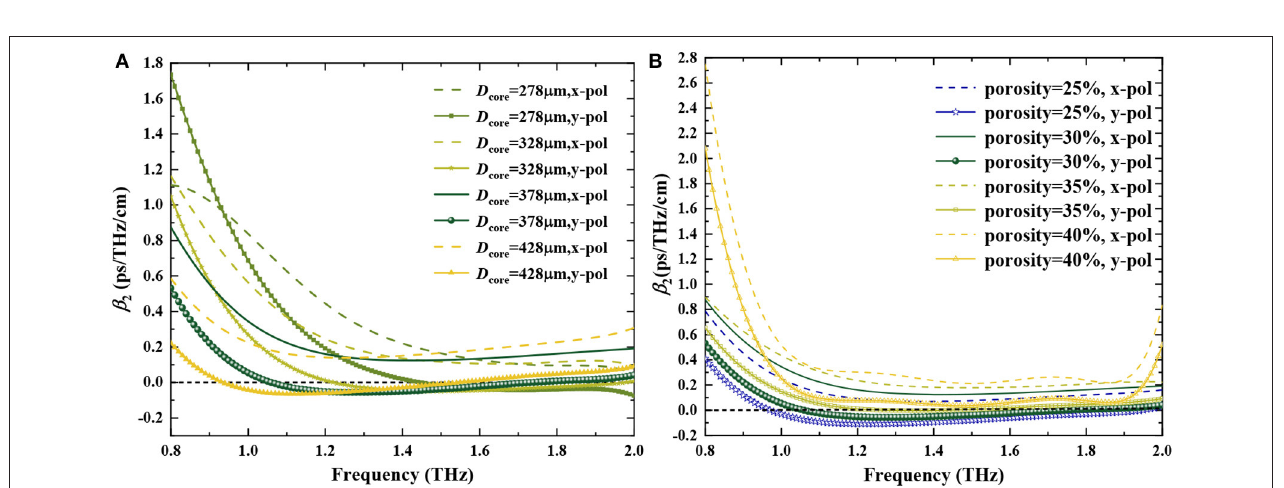
FIGURE 4 | Birefringence vs. frequency of the proposed fiber (A) for different D core at P = 30%, (B) for different core porosity at D core = 378 µ m.